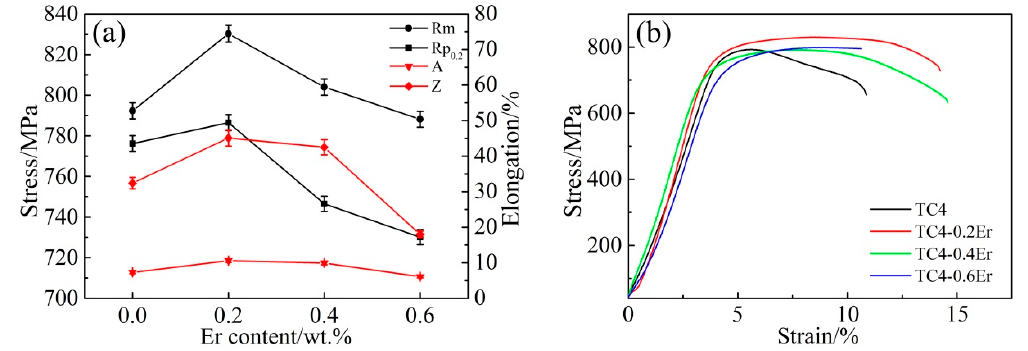
Figure 11. ( a ) Room temperature tensile properties of Ti6Al4V- x Er casting alloys; ( b ) stress–strain curves of Ti6Al4V- x Er casting alloys.